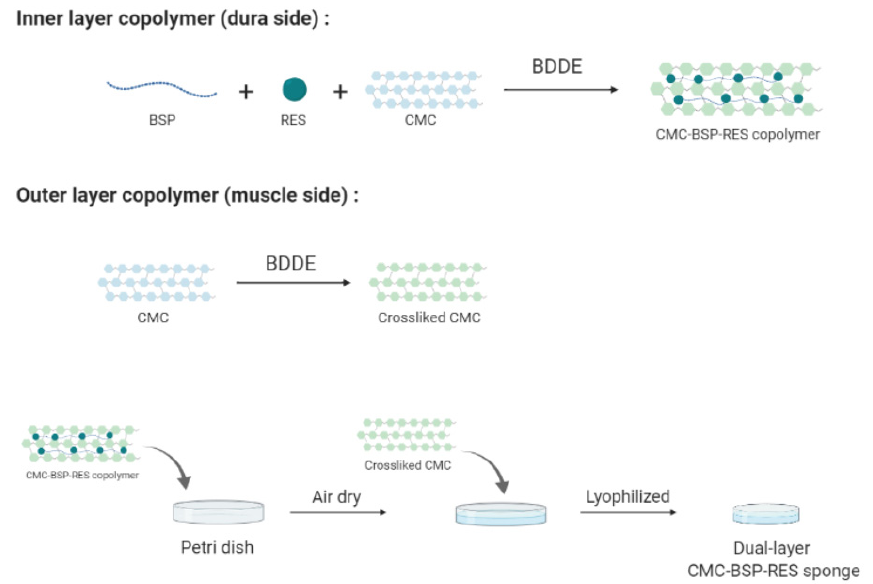
Figure 3. Schematic of the formation of a dual-layer CMC-BSP-RES sponge. 2.4. Cultivation of Cell Lines Four different cell lines, NIH/3T3 fibroblasts (60008; BCRC, Hsinchu, Taiwan), C2C12 myoblasts (60083; BCRC), PC-12 neural cells (60048; BCRC), and RSC96 Schwann cells